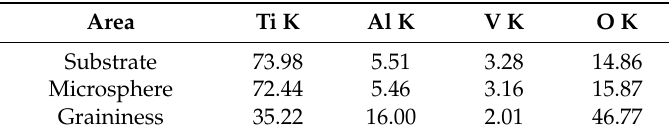
Table 1. EDS determination of the element content of the different areas of the three-dimensional (3D)-printed surface.